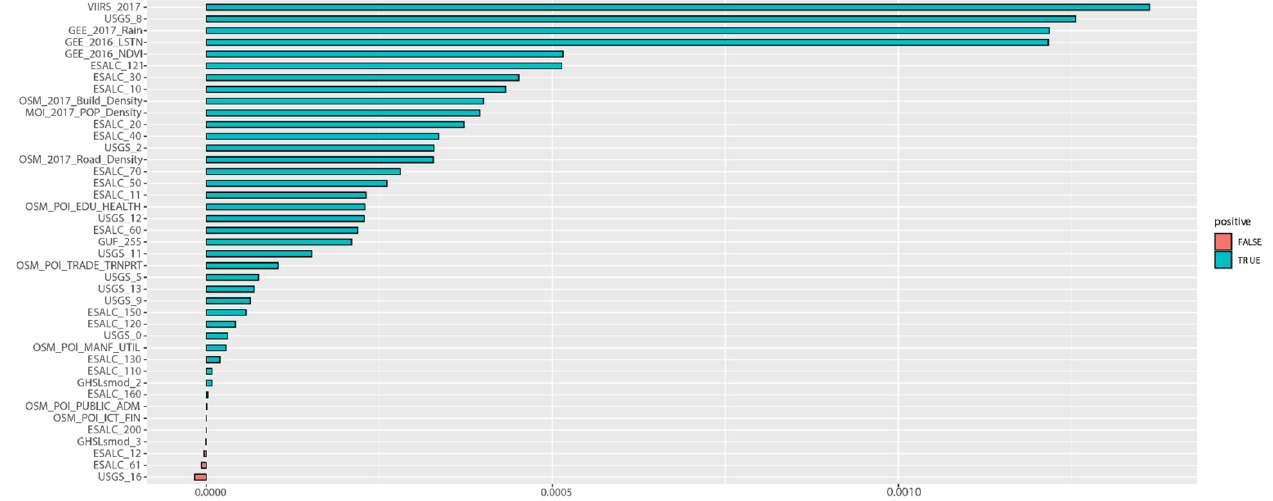
Figure 20. Result of Variable Importance (VIMP) analysis on predicting MPI of 2017 (based on RF’s outcome). Source: Calculation and graphics generated by authors. outcome). Source: Calculation and graphics generated by authors.